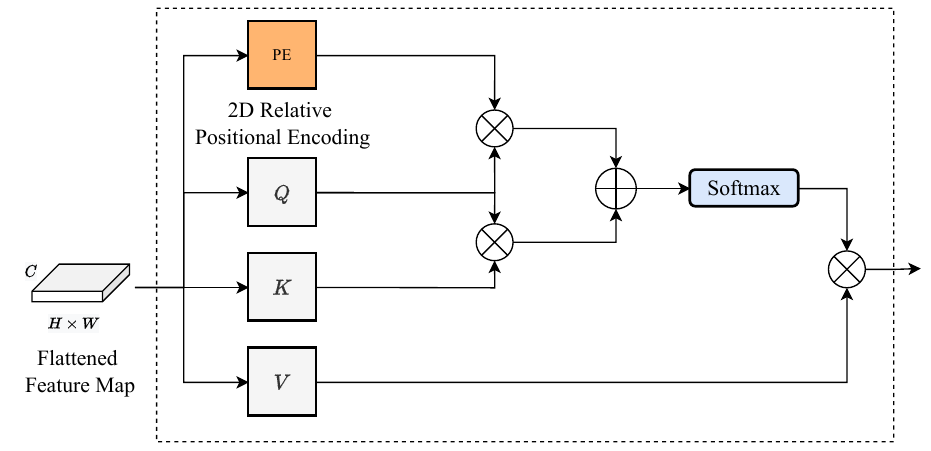
Figure 6. Illustration of self-attention modules with 2D relative position